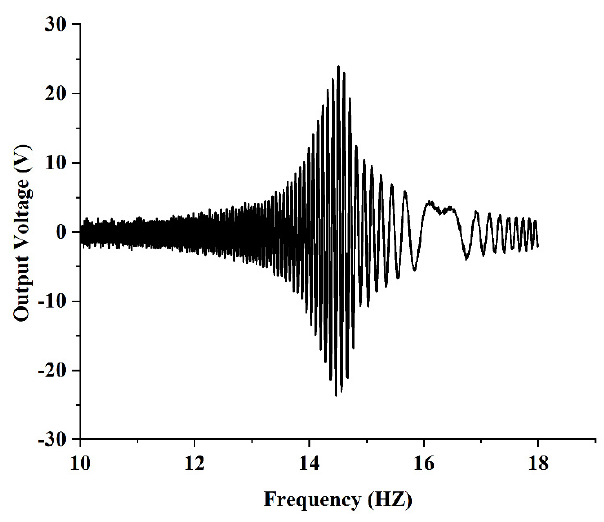
Figure 15. Frequency sweep experiment.